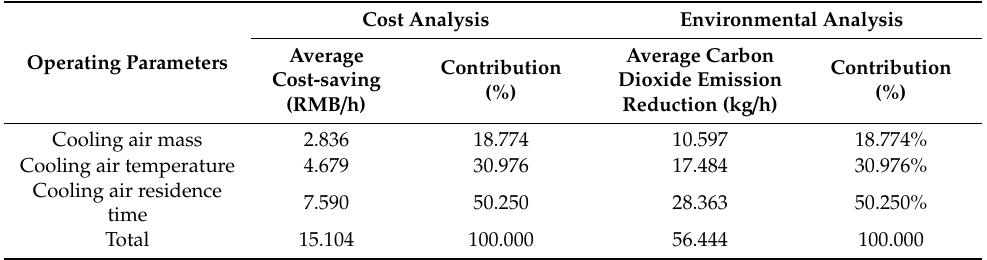
Table 12. Cost analysis and environmental analysis for di ff erent operating parameters.